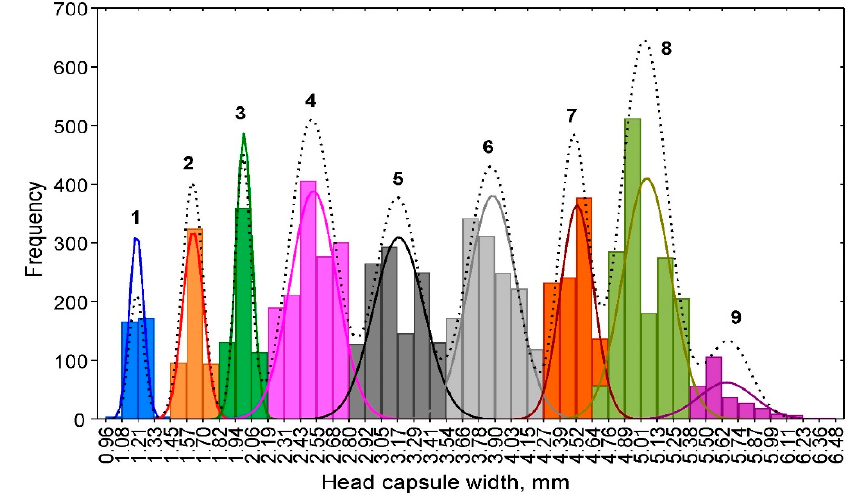
Figure 2. Frequency distribution of the observed Dendrolimus pini head capsule widths with fitted functions for each separate instar (the line color is the same as the column color) and the overall distribution based on non-linear least squares (NLLS) parameter estimates (black dotted line); the numbers indicate larval instars. Table 2. Observed and estimated values for the means, standard deviations (SD), and limits of the head capsule widths (mm) of Dendrolimus pini larvae.